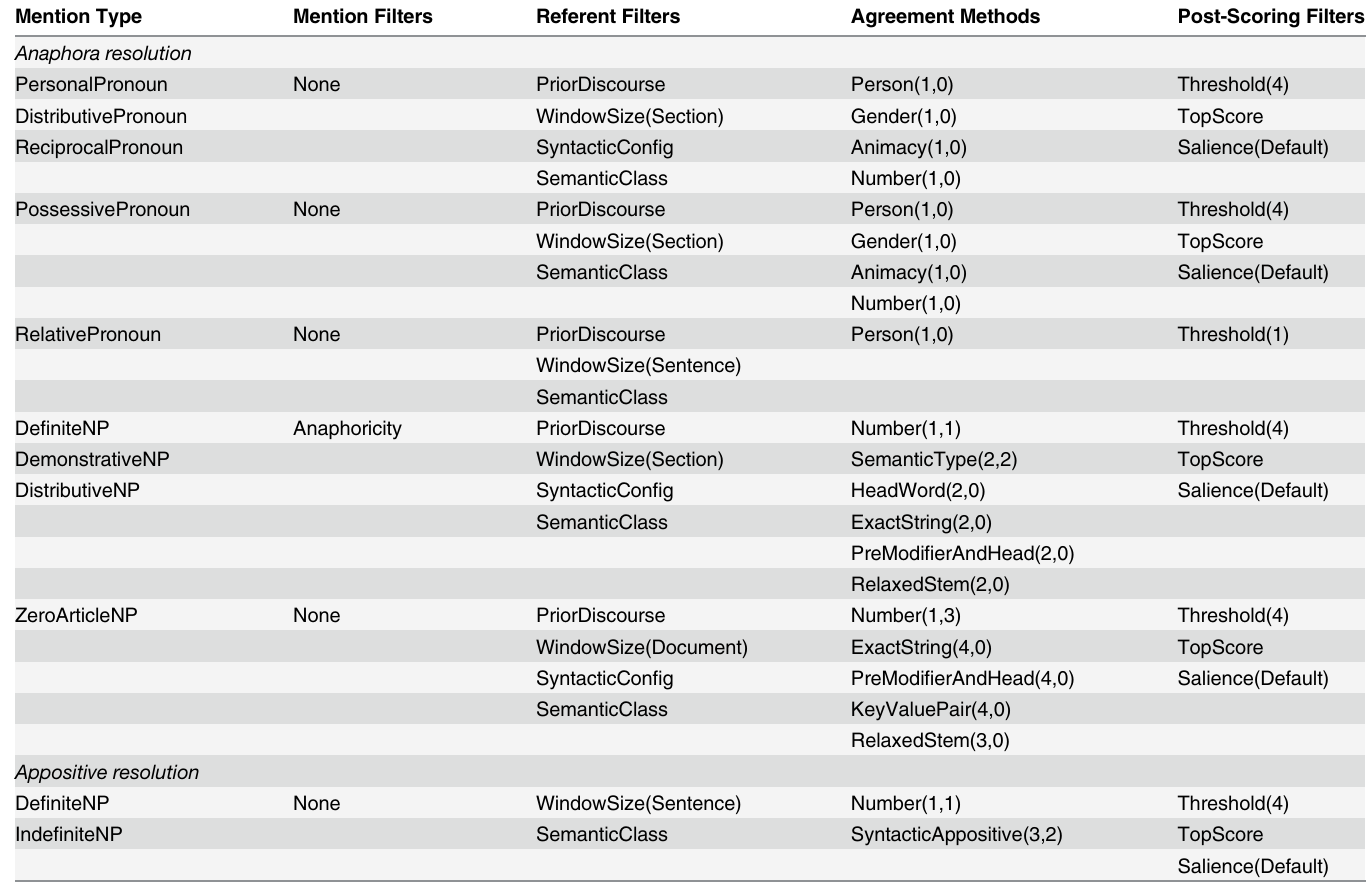
Table 12. Configuration for coreference resolution in discharge